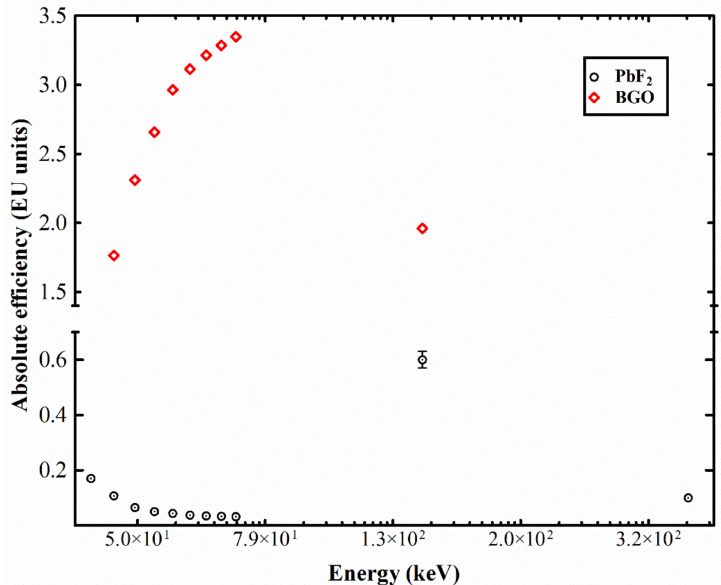
Figure 4. X-ray absolute luminescence efficiency of PbF 2 and BGO crystals in the X-ray (42–71 keV) and nuclear medicine (140 keV Tc-99m, 365 keV I-131) energy